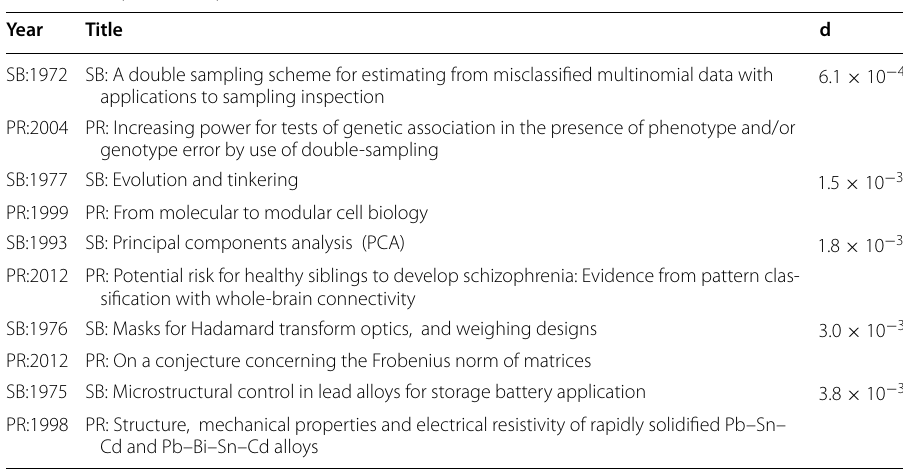
Table 10 Top 5 SB–PR pairs with the highest d Year Title d SB:2013 SB: Algorithm for automaton specification for exploring dynamic labyrinths PR:2017 PR: Construction of cellular automata over hexagonal and triangular tessellations for path planning of multi-robots SB:1973 SB: Digital pachydermia of the first phalanges from dermic connective tissue hyperplasia and hypodermic aplasia PR:2014 PR: Pachydermodactyly successfully treated with triamcinolone injections SB:1981 SB: The theory of uranium enrichment by the gas centrifuge PR:2011 PR: The generalized Onsager model for the secondary flow in a high-speed rotating cylinder SB:1980 SB: Onsager’s pancake approximation for the fluid dynamics of a gas centrifuge